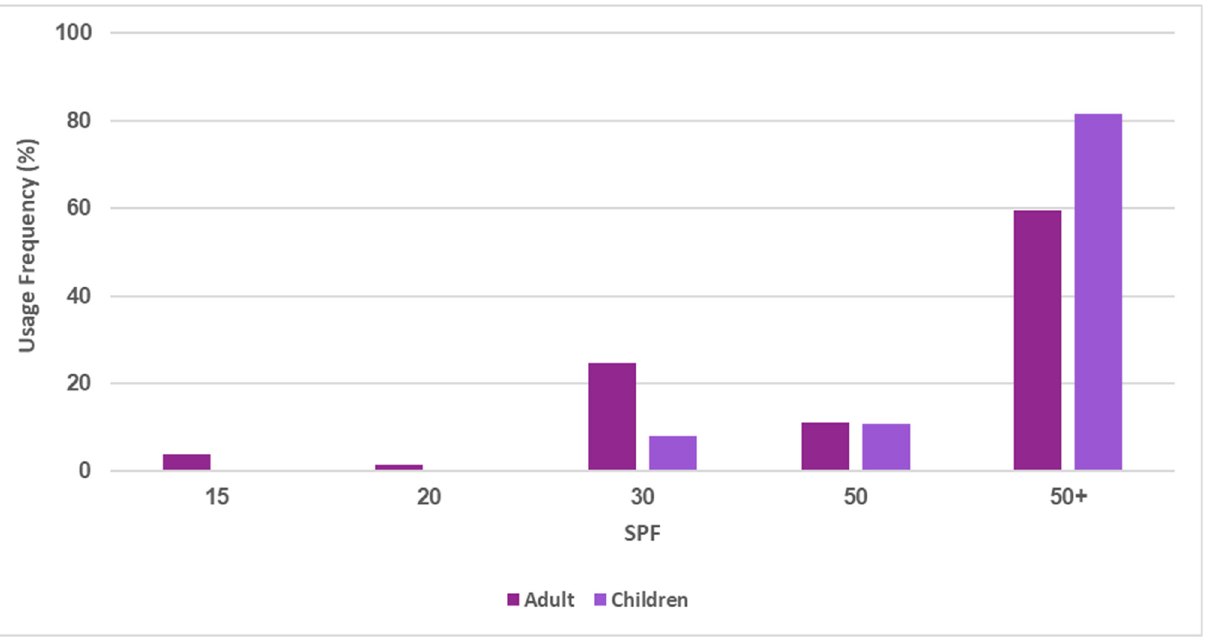
Figure 5. Frequency of SPF values in adults’ and children’s sunscreens.